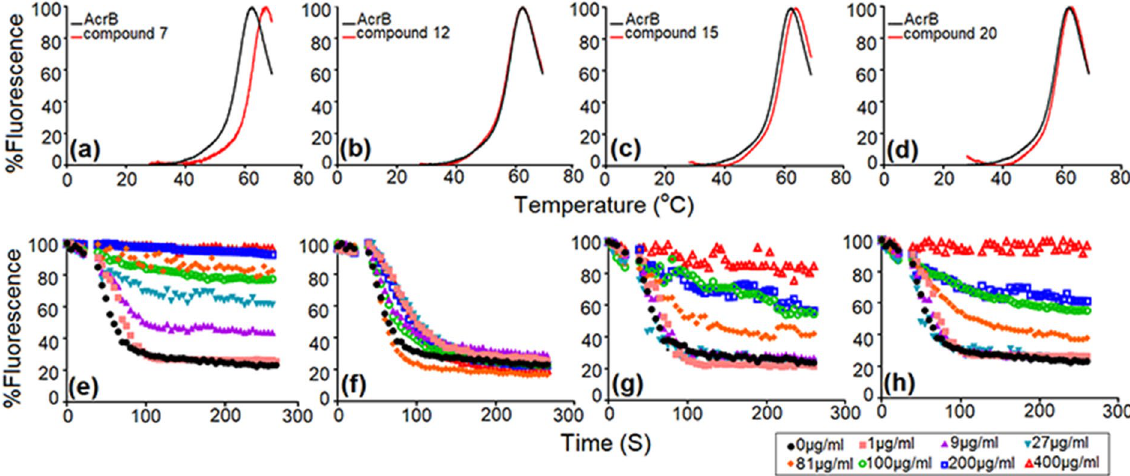
Figure 3. Evaluation of AcrB binding and efflux liability of NTC derivatives. Thermal shift assay ( a – d ), shows the melting curve of the AcrB apo-protein in black and with the compounds in red. A ∆ Tm of > 1 ° C implies binding and ∆ Tm of < 1 °C implies no binding; ( a ) ∆ Tm = 4.13 °C for compound 7, ( b ) ∆ Tm = 0.68 °C for compound 12, ( c ) ∆ Tm = 1.75 °C for compound 15 and ( d ) ∆ Tm = 1.86 °C for compound 20. Efflux assay ( e – h ), the curves depict time-dependent competition of Nile red with compounds in E. coli BW25113. Concentration of compound that is required for complete inhibition of Nile red efflux (i.e., T efflux50 > 200 seconds); ( e ) 9 μ M table of T efflux50 at all tested concentrations of compounds is shown in supplementary Table S2.